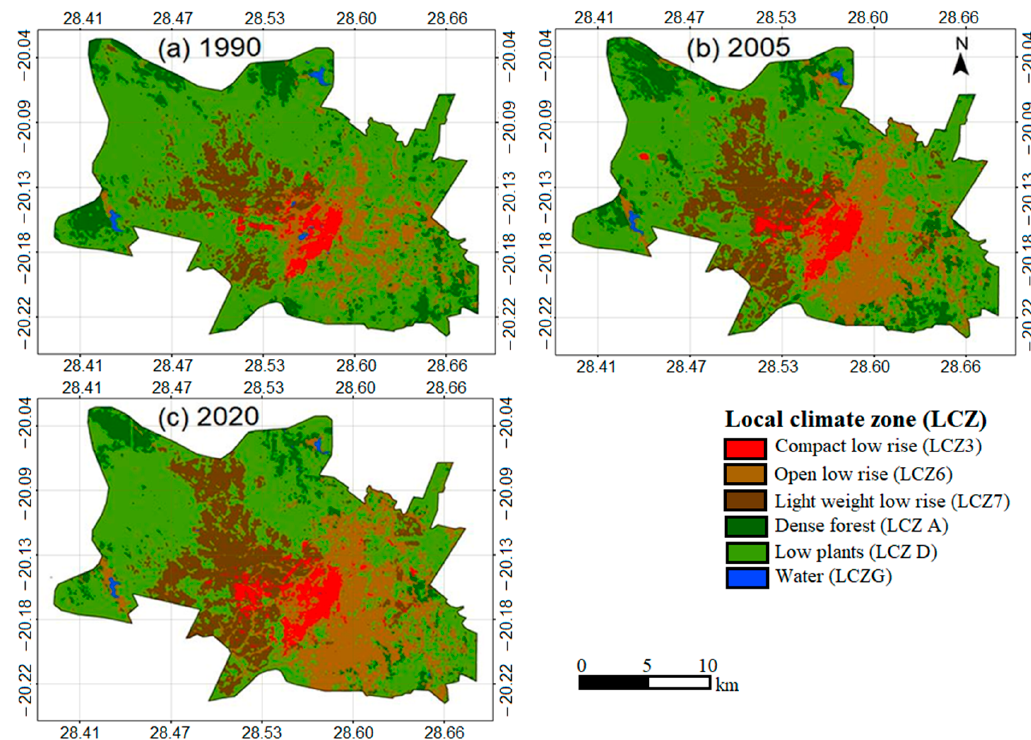
Figure 3. LCZ maps produced using multi-seasonal remotely sensed data. Table 2. Coverage of LCZ categories in 1990, 2005 and